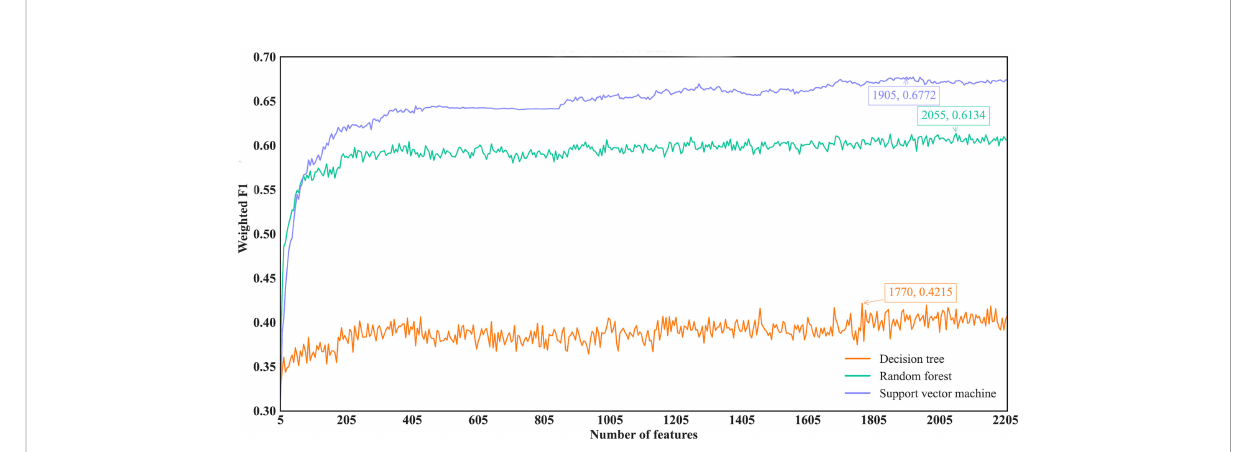
FIGURE 3 IFS curves of different classi fi cation algorithms on the Lasso feature list. Three classi fi cation algorithms provided highest weighted F1 values of 0.4215, 0.6134 and 0.6772, respectively, based on top 1770, 2055 and 1905, respectively, features in the list.